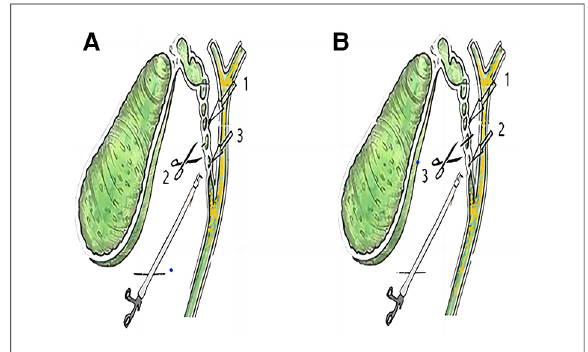
FIGURE 2 Order of the clamp placements on the cystic duct. ( A ) “ semicut ” skill on the cystic duct; ( B ) traditional procedure on the cystic